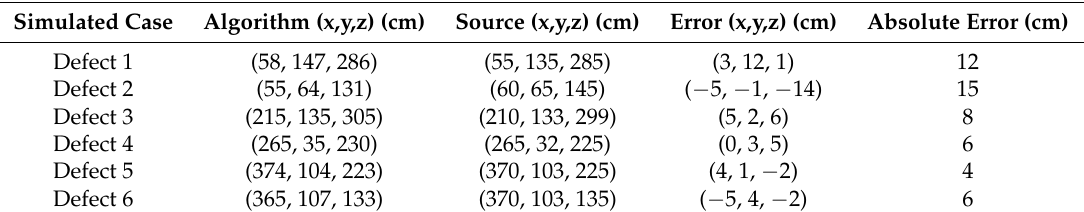
Table 3. Results obtained from the localisation algorithm.